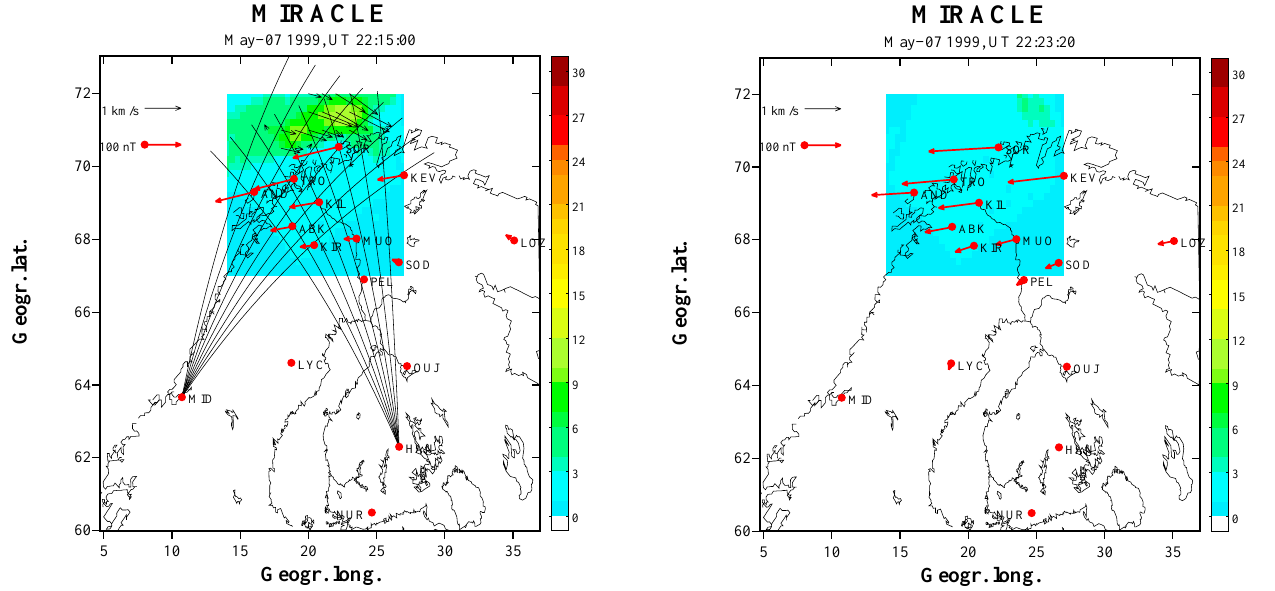
Fig. 2. Plasma drift vectors and equivalent currents deduced from the MIRACLE observations at 22:15:00 UT (a) and at 22:23:20 UT (b) .